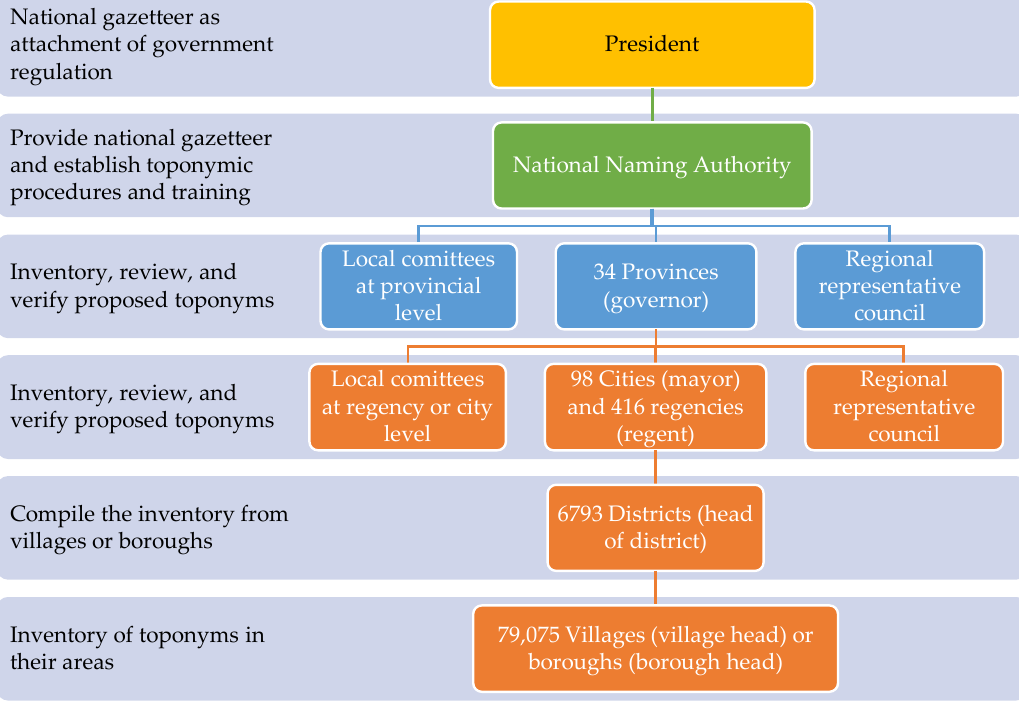
Figure 2. Organizational structure of public authorities for the standardization of toponyms in Indonesia.